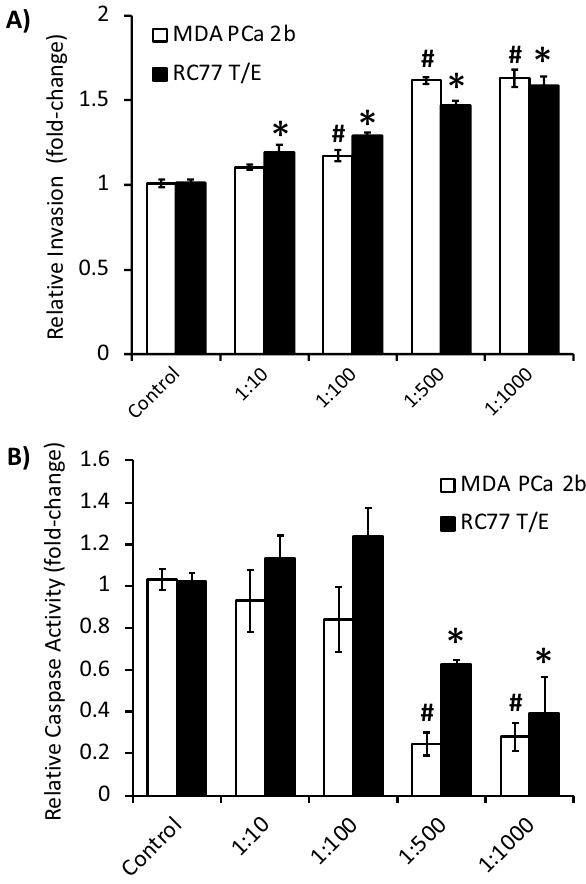
Figure 3. Platelets increase invasion and decrease caspase activity in PCa cells. ( A ) Platelet-stimulated PCa cell invasion. Invasion was determined by Matrigel assay. Data presented as the mean ± SEM of n = 4–7 independent determinations at the indicated PCa cell:platelet ratios and analyzed by ANOVA and Dunnett’s post-hoc test. * or # , P < 0.05; significantly different from corresponding control. ( B ) Platelet-induced PCa cell apoptotic resistance. Apoptotic resistance was determined by caspase 3/7 activity assay. Data presented as the mean ± SEM of n = 4–9 independent determinations at the indicated PCa cell:platelet ratios and analyzed by ANOVA and Dunnett’s post-hoc test. * or # , P < 0.05; significantly different from corresponding